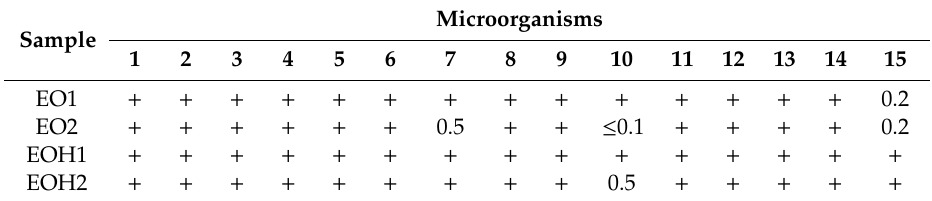
Table 3. Antimicrobial study results of nutmeg essential oil and its hydrolats.